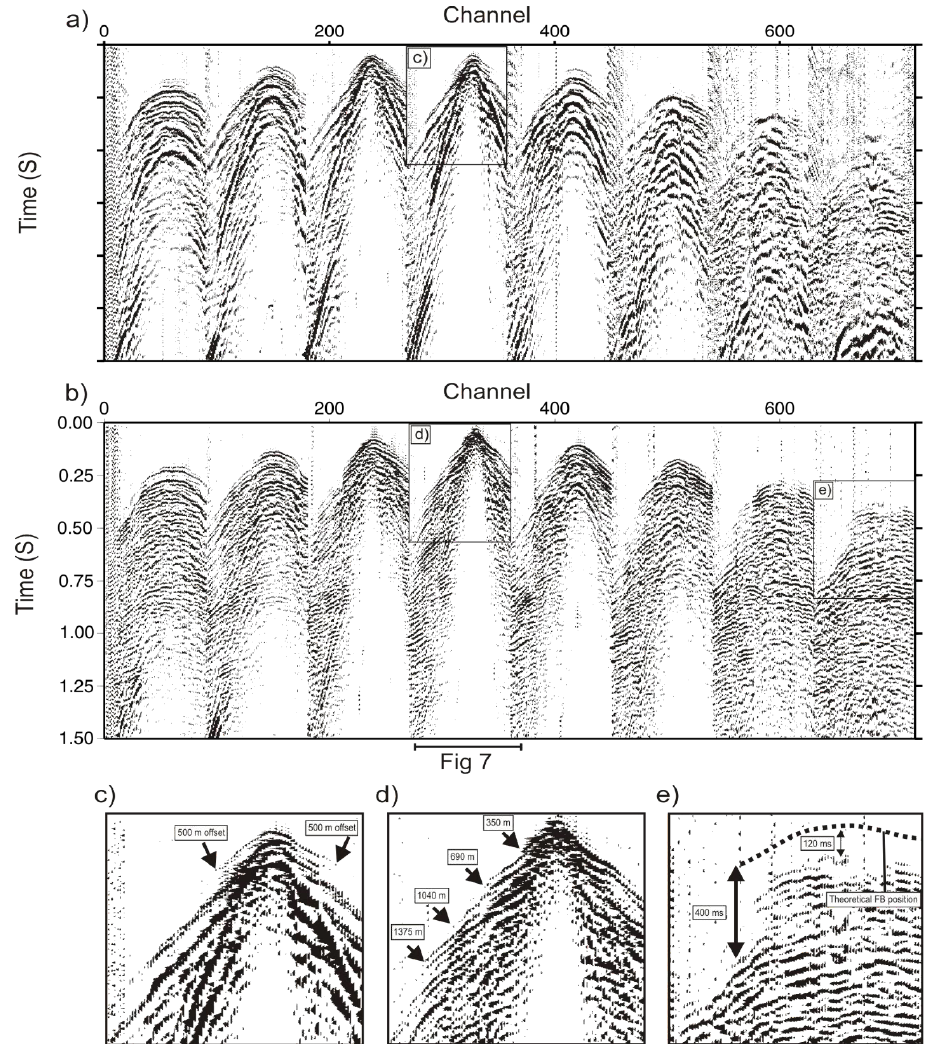
FIG. 3: Raw shot gather 1158, acquired with explosive source (a), and the co-located shot gather 1820, acquired with Vibroseis source (b). Three zooms from different zones of the two shots are shown in (c), (d) and (e), with black arrows indicating the observed loss of first arrivals and the resultant shadow zone. The location of shot gathers 1158 and 1820 is marked in Fig. 2.